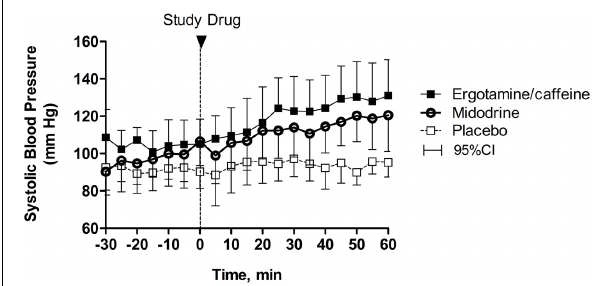
FIGURE 1 | Changes in seated blood pressure following drug administration. The combination of 1mg ergotamine and 100mg caffeine increased seated systolic blood pressure over time compared with placebo in patients with severe autonomic failure ( p = 0 . 003). Similarly, 5–10mg midodrine increased seated systolic blood pressure in these patients ( p = 0 . 015), but this effect was not different from ergotamine/caffeine ( p = 0 . 621). Data are presented as mean ± 95% confidence